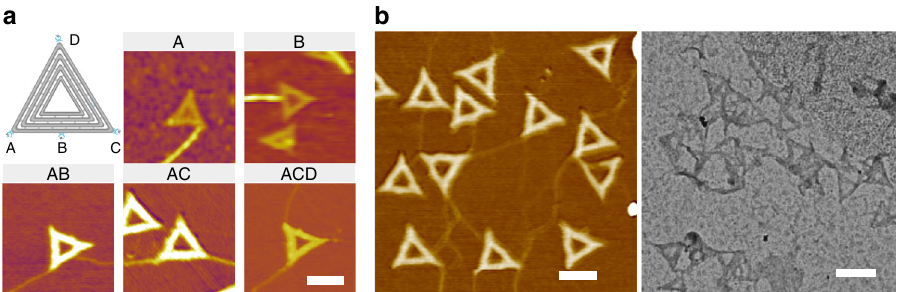
Fig. 6 Nucleation-directed polymerization of CsgA with designer CB-origami. The assembled structures shown in AFM height and TEM images correspond to the schematics representative of the CB-origami structures applied. a Schematic of the applied origami structure containing a variable number of CsgB site-speci fi cally anchored along the edge of the (left) triangular DNA origami and corresponding AFM images of the assembled structures. The annotated A, B, AB, AC, or ACD on top of the AFM images stands for the applied origami structure with CsgB anchored at the speci fi cally designated positions shown in the schematic. b Typical DNA origami- fi bril complex structures formed by polymerization of CsgA monomers (2.0 μ M) in the presence of CB-origami, with CsgB tethered at the three vertexes. Scale bars: 100 nm. Note: AFM imaging was performed in tapping mode